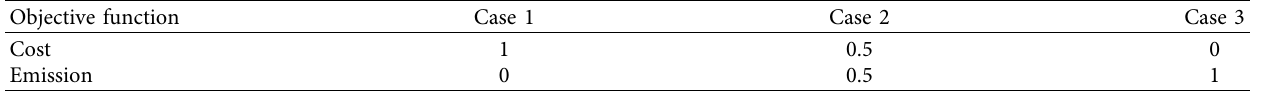
Table 15: Weighting coefcients of objective functions for IEEE 118-bus system.